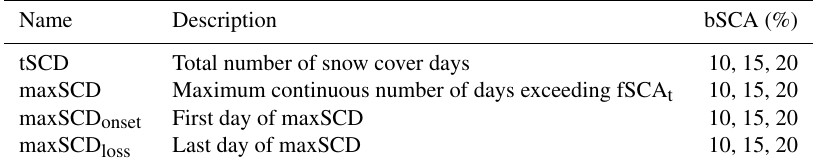
Figure 3. Individual mountain ranges mapped out within the Clutha Catchment for analysis of SCD variability and temperature and precip- itation sensitivity. The end point for HYSPLIT back-trajectories is also shown. Elevation and relief data from Columbus et al. (2011); lakes outlines and geographic place names are sourced from the LINZ Topographic Database. Table 1. Basin-wide snow-covered area (bSCA) temporal metrics. These metrics were calculated annually, per